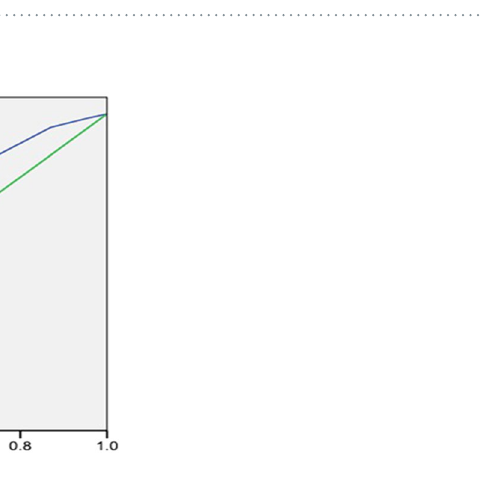
Table 2. Ultrasonographic nodule characteristics with or without cervical LNM. LNM: lymph node metastases. CEUS: contrast-enhanced ultrasound. US: ultrasound. ECE: extracapsular extension.